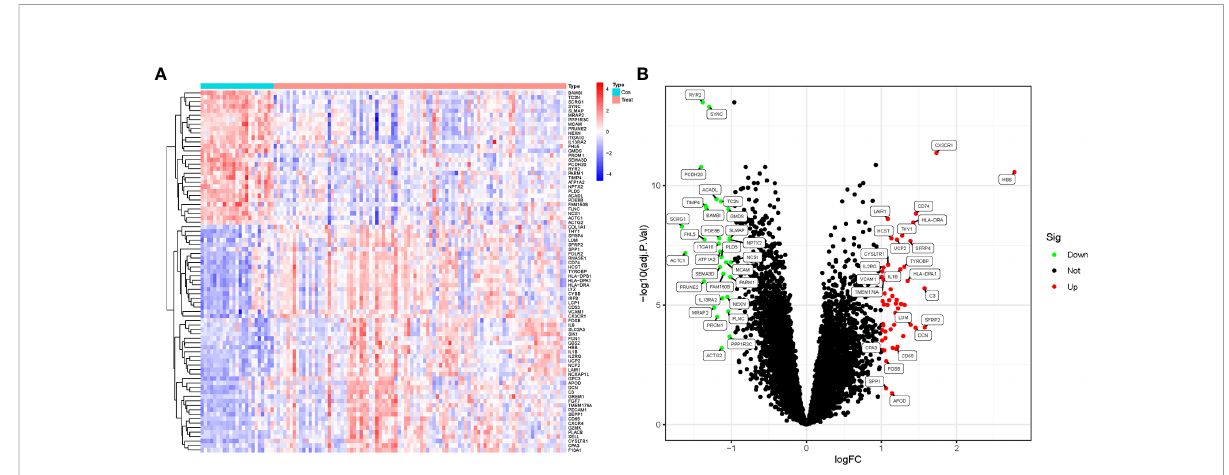
FIGURE 1 DEGs screening in AAA and TAA. (A) Heatmap of DEGs expression in aortic aneurysm (Treat) and non-aortic aneurysm (Con) groups. (B) Volcano plots of DEGs expression in Treat and Con